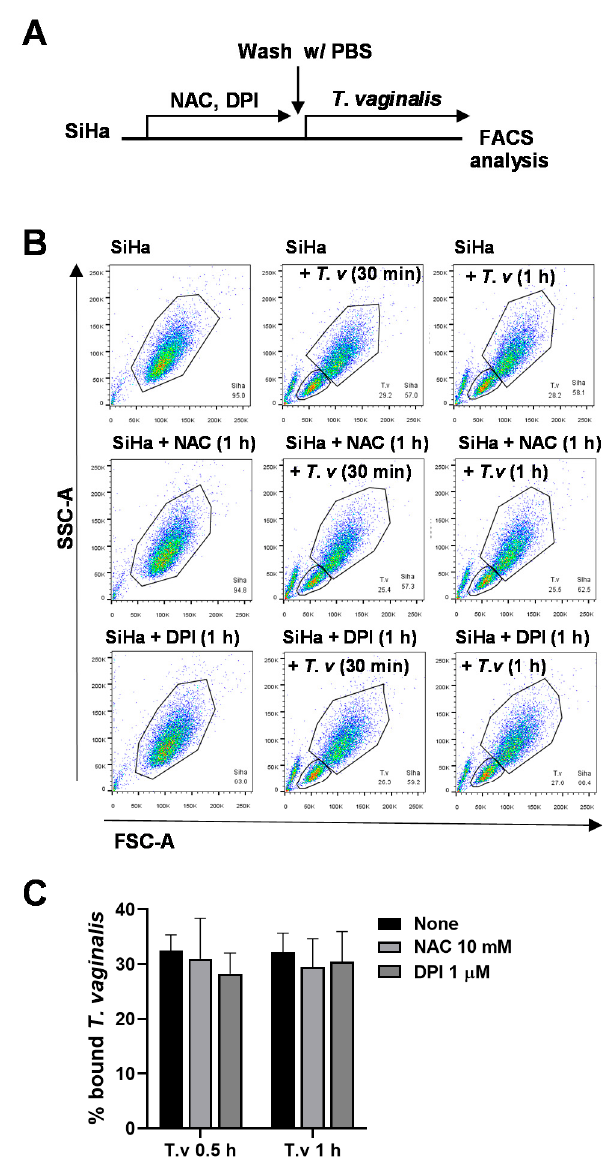
Figure 3. Pretreating SiHa cells with DPI did not affect T. vaginalis adherence. ( A ) Experimental scheme: SiHa cells were pretreated with 10 mM NAC and 1 μ M DPI for 1 h. After washing with PBS, pretreated cells were infected with T. vaginalis for 30 min or 1 h and subjected to flow cytometry analysis. ( B ) FSC-A and SSC-A dot plots for SiHa cells and T. vaginalis populations. ( C ) Bound T.